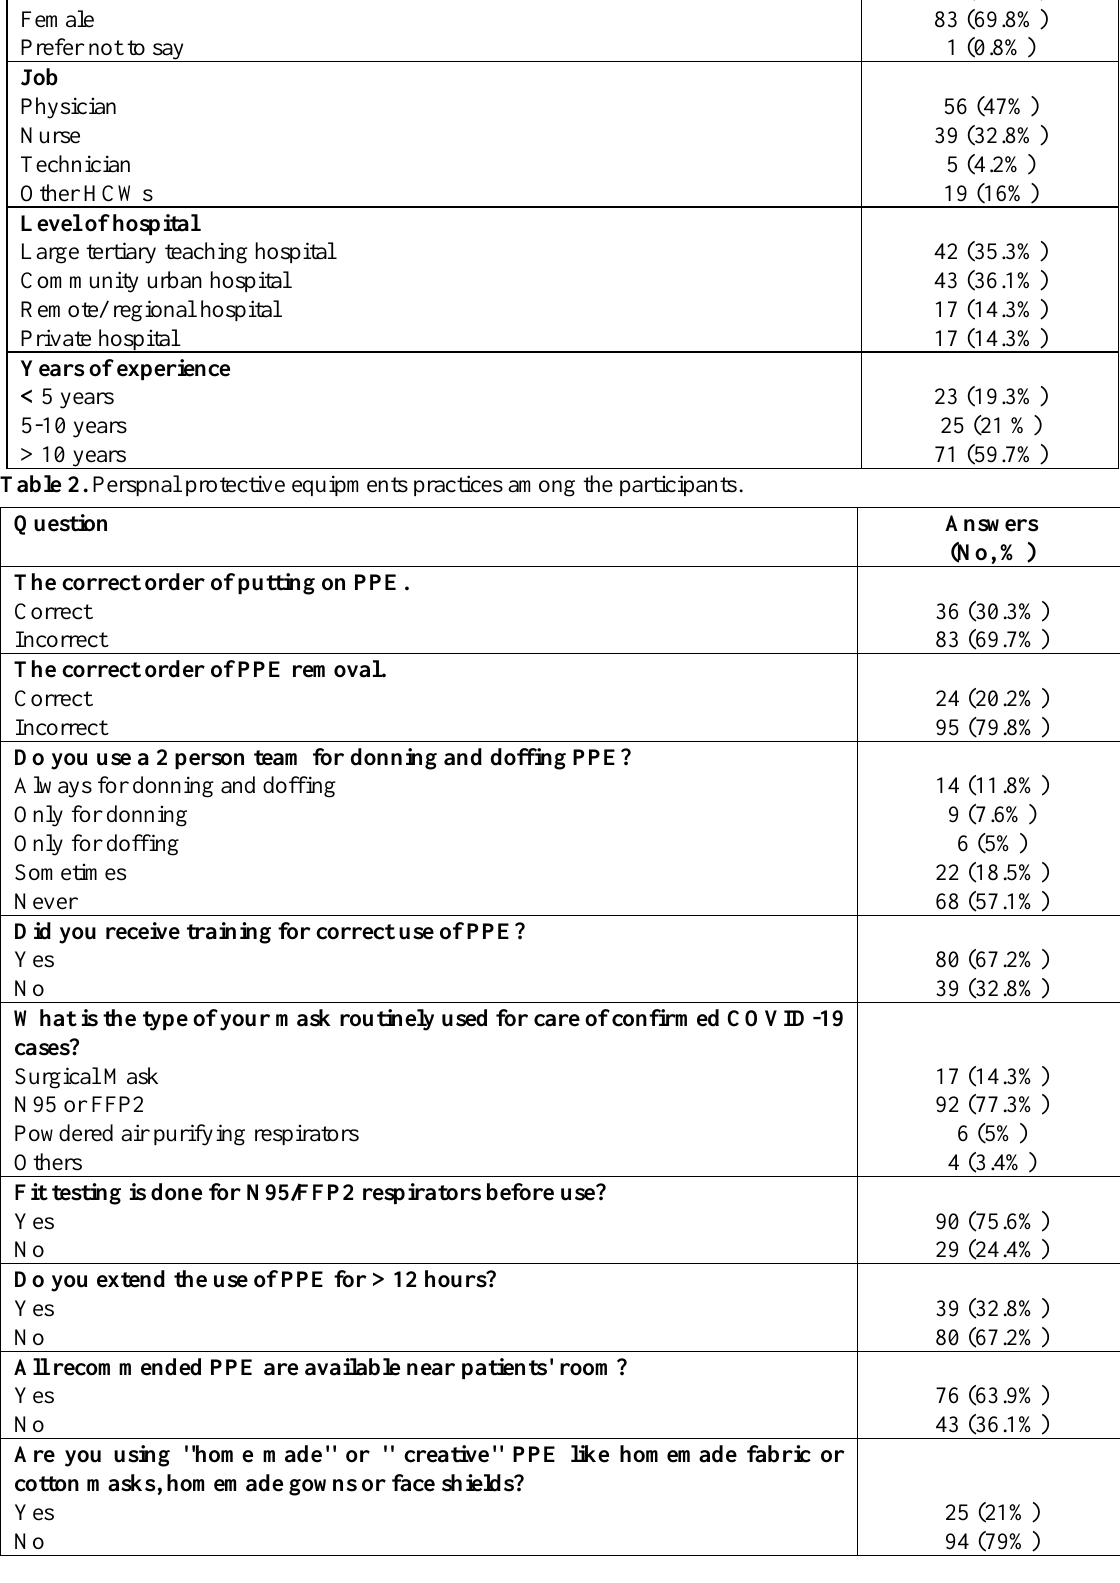
Table 1. Baseline demographic criteria of the study participants. Parameter